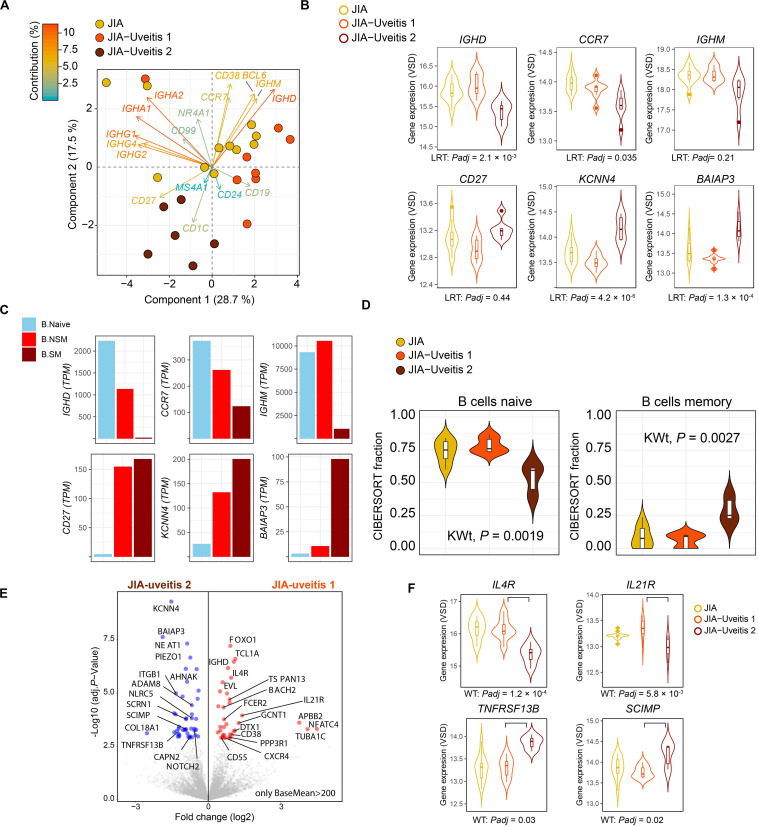
Heterogeneity in key B cell memory genes in JIA cases with uveitis. (A) Principal component analysis biplot of JIA cases with and without uveitis based on the expression data of 17 genes associated with B cell subsets. The contribution (in %) of each gene to the components is indicated. Two subgroup of uveitis cases are indicated in dark red and orange. (B) Gene expression for CCR7, CD27, KCNN4, BAIAP3, IGHM, and IGHD genes in JIA and the two JIA-uveitis clusters. LRT; likelihood ratio test from DESeq2 considering the JIA and the two JIA-uveitis clusters, Padj; FDR corrected P-values. (C) The median gene expression (TPM values) for genes of (B) in Naive B cells (B Naive), non-switched memory B cells (NS Mem), and switched memory B cells (S mem) from Monaco et al. (24). (D) Deconvolution-based estimation by CIBERSORT (25) of naive and memory B cells fraction for JIA and the two JIA-uveitis groups identified by the PCA analysis (D) under (A). KWt, Kruskal–Wallis test. (E) Volcano plot of differentially expressed genes (DEG) from the head-to-head comparison of the JIA-uveitis cluster 1 versus JIA-uveitis cluster 2 (A). The 10,859 high expressed genes (BaseMean >200 from DESeq2) are indicated in gray. DEGs are indicated in red (increased expression) and blue (decreased in expression). (F) Gene expression for IL4R, IL21R, SCIMP, and TNFRSF13B in JIA and the two JIA-uveitis clusters. WT, Wald’s test from DESeq2 considering head-to-head comparison of the newly identified two JIA-uveitis clusters, Padj, FDR corrected P-values.